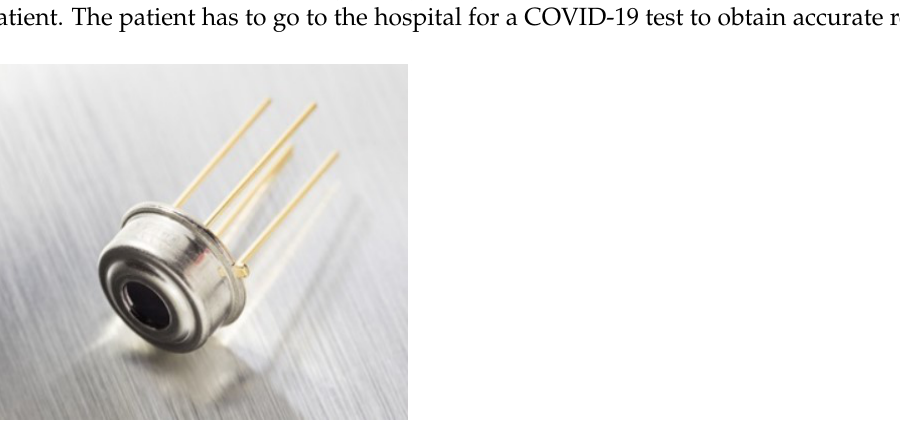
Figure 5. Melexis MLX90614: an infrared thermometer for non-contact temperature measure- ments [36].